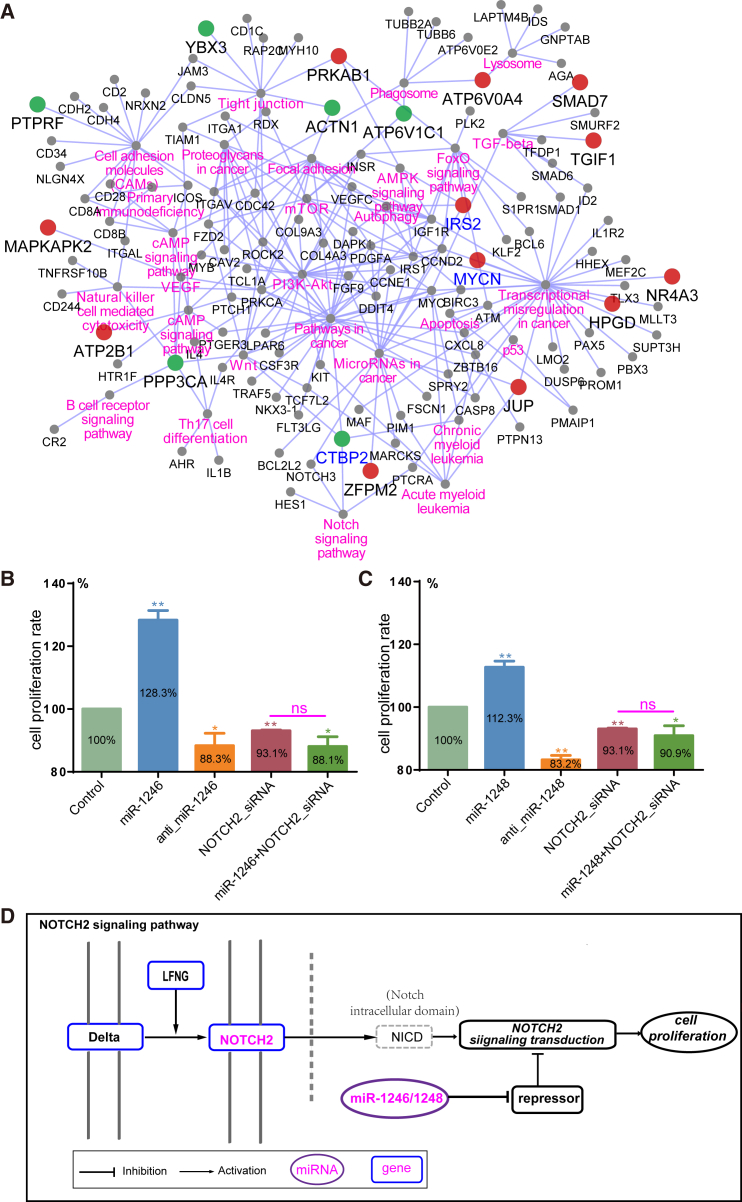
The Crosstalk Analysis for Remission Gene Set and Experimental Verification(A) KEGG pathway network formed by remission gene sets. Red nodes, upregulation in relapse; green nodes, downregulation in relapse; gray nodes, non-DEGs; pink labels, KEGG pathways. (B and C) Effects of miR-1246 (B) and miR-1248 (C) and NOTCH2 on cell proliferation in the Jurkat cell line. The numbers in the bar represent the means. Values represent the means ± SD (**p < 0.001 and *p < 0.01; ns, not significant). (D) NOTCH2-signaling pathway and possible mechanism of miR-1246/1248 on T-ALL relapse.